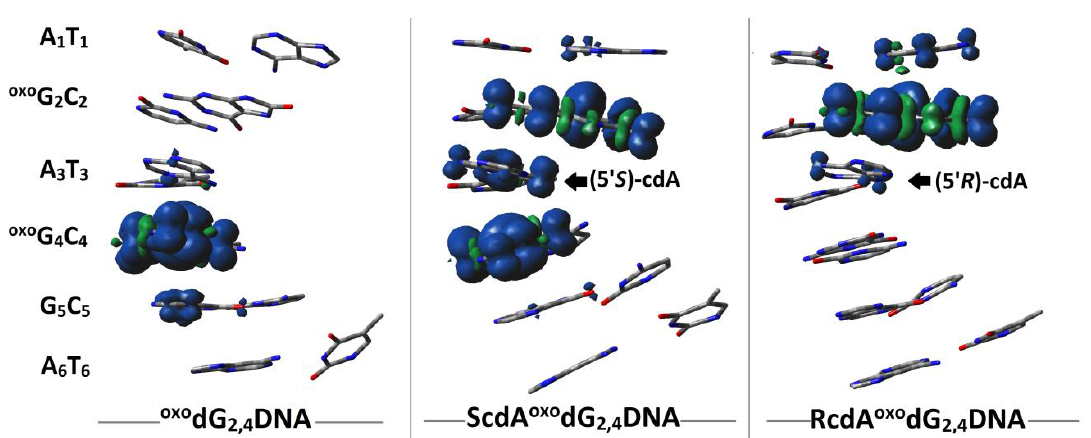
Figure 6. Graphical representation of spin density distribution for the vertical radical cation form of ds -oligos.